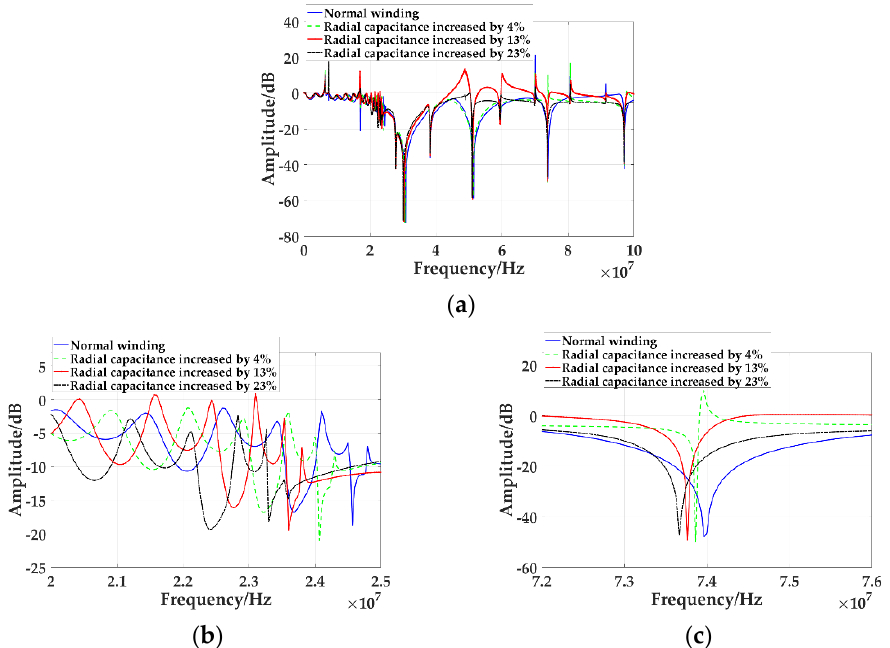
Figure 11. Frequency response curves of different degrees of axial offset of winding: ( a ) Frequency response curve from 0 MHz to 100 MHz ; ( b ) Frequency response curve from 20 MHz to 25 MHz ; ( c ) Frequency response curve from 72 MHz to 76 MHz .